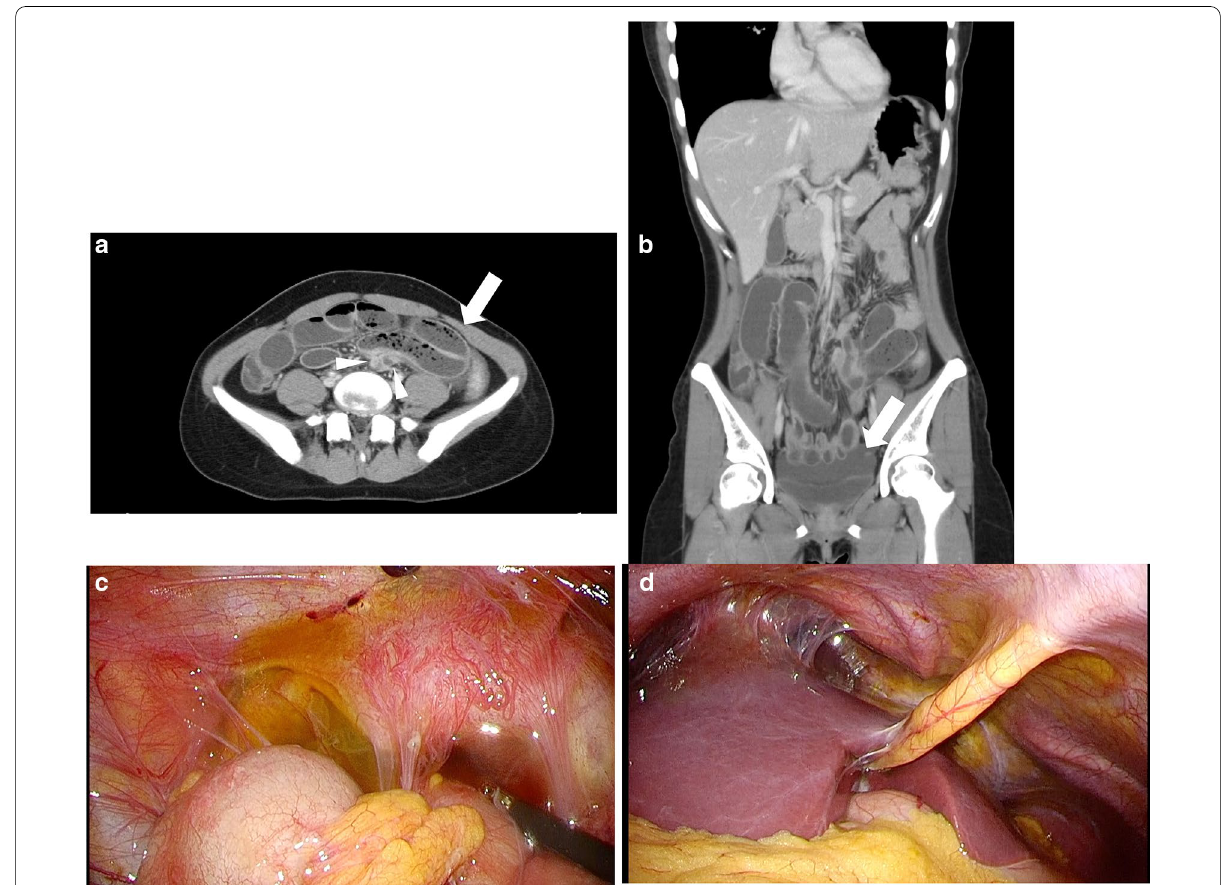
Fig. 1 Abdominal CT and intraoperative findings. a arrow: Closed loop formed and dilated small intestine, arrowheads: Collapsed small intestine on the oral and anal sides of the closed loop, b ascites in the pelvis, c ascites in the pelvis and adhesion of the uterine appendages, and d adhesions that are translucent and considered to be in the active stage of chlamydial infection on the liver